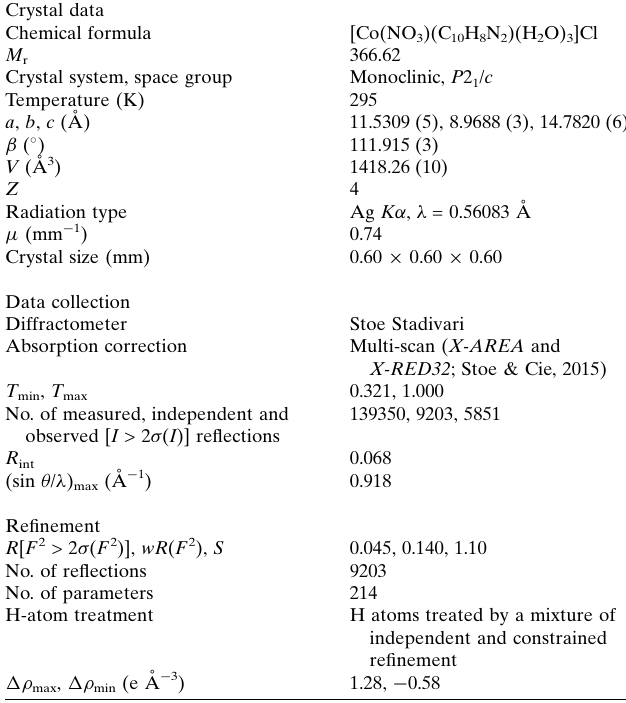
Table 2 Experimental